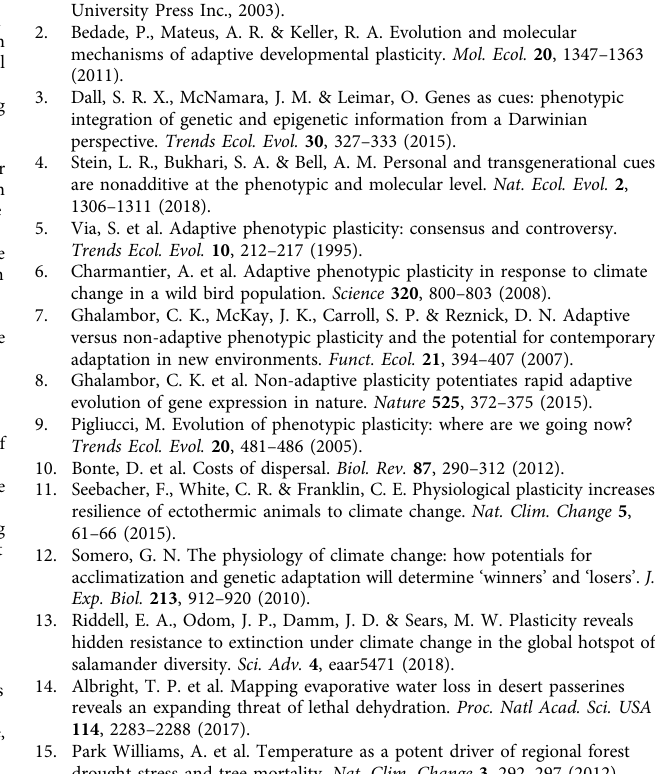
RNSMK. Figure 2 requires the available data from http://www.climatologylab.org/ products.html. RNA-seq data is currently available for download on Genbank (BioProject: